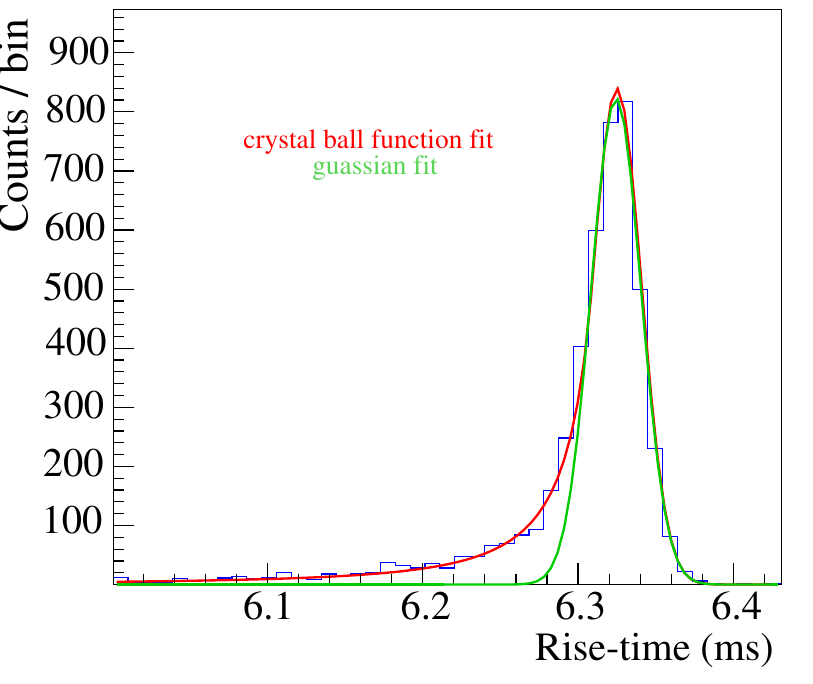
Figure 10 . Rise-time distribution for neutron-capture events collected by Detector 1 of table 1. The distribution is (cid:12)tted with a Crystal Ball function. The tail at faster rise-time values contains close-to-Al-(cid:12)lm events, while the main Gaussian peak contains bulk